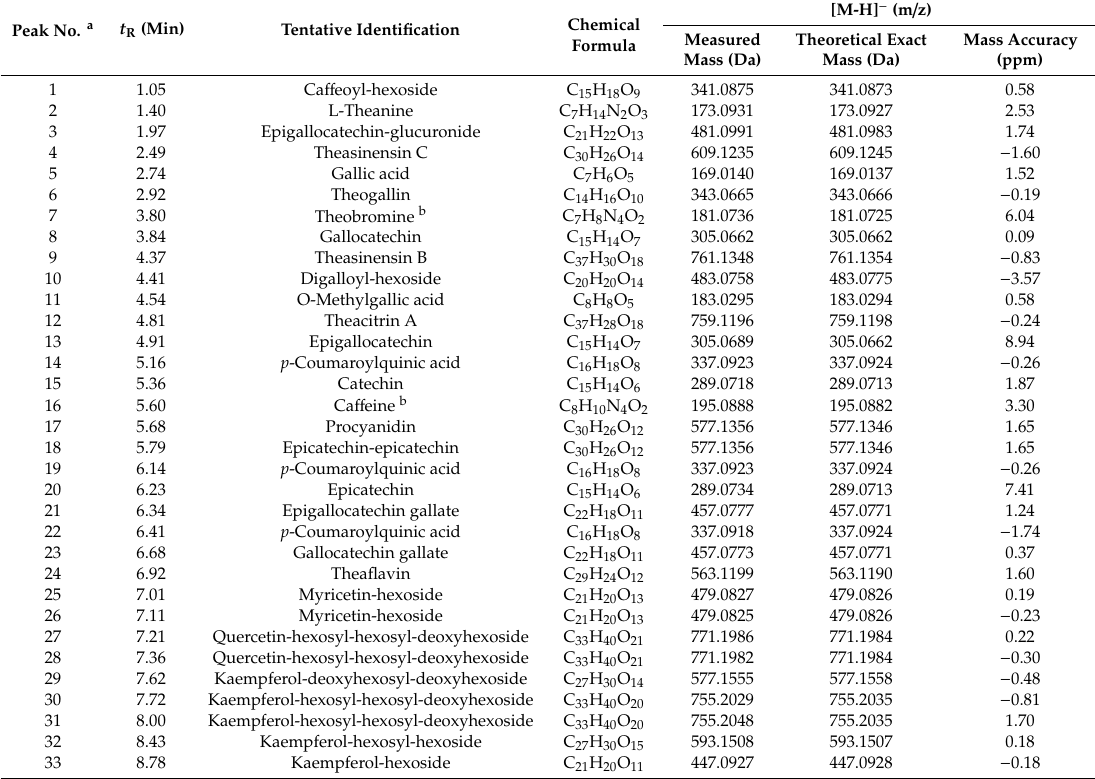
Table 1. The phenolic profiles of the oolong tea